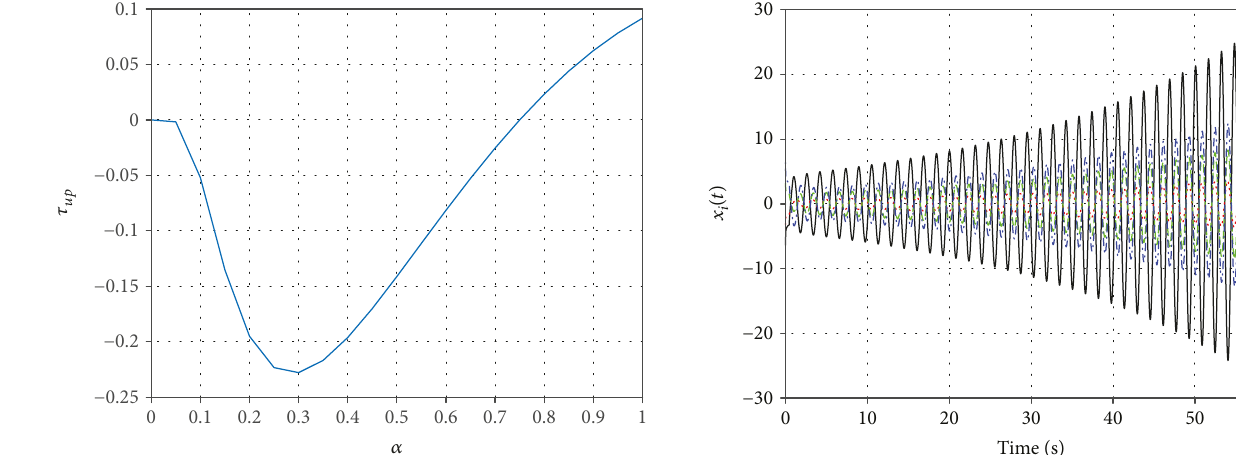
Figure 4: The relationship between τ